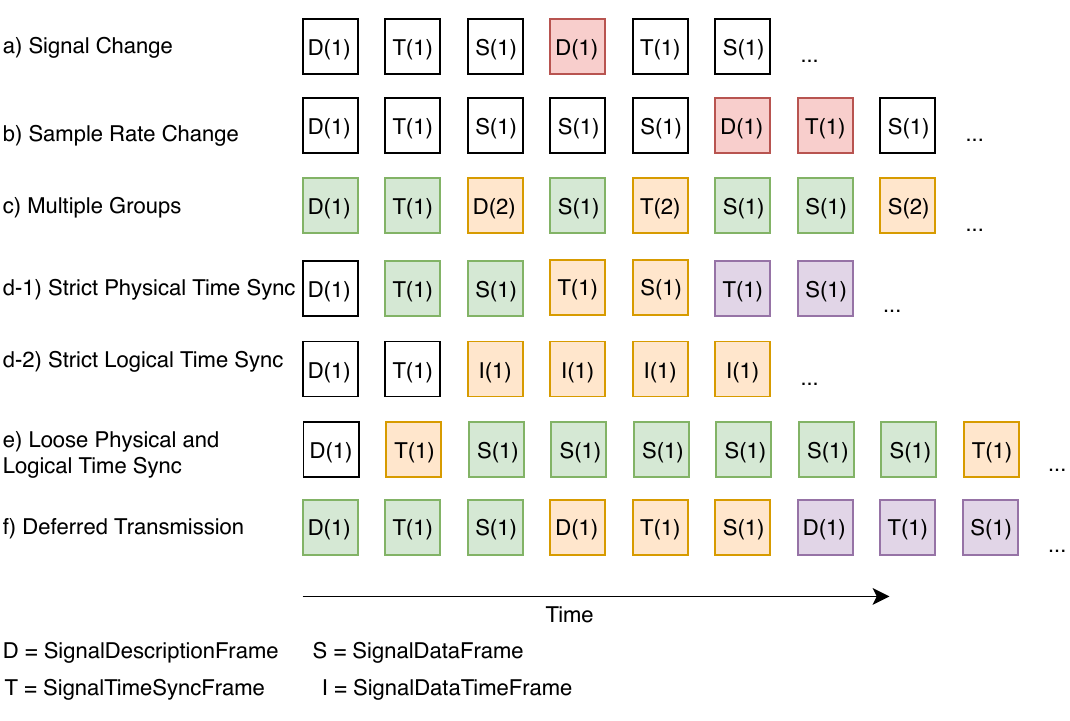
Figure 11. Examples of BTTM